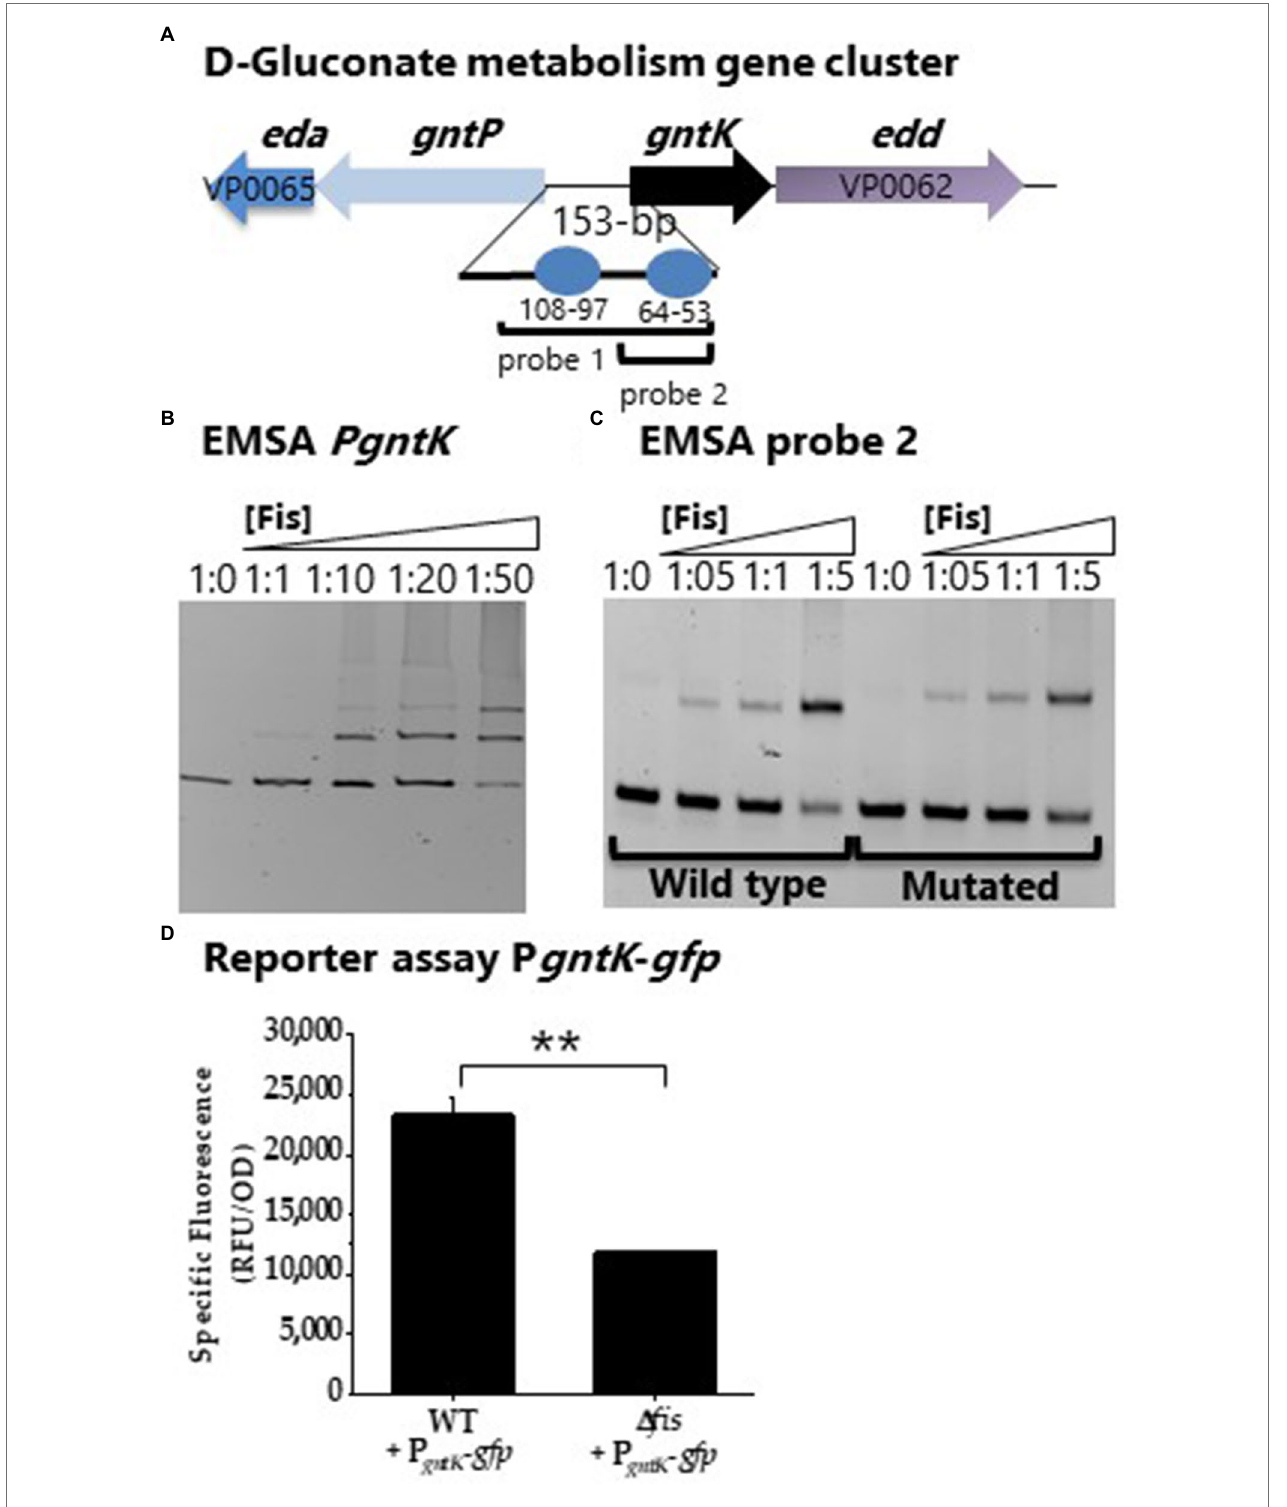
FIGURE 9 | Fis is a positive regulator of gntK . (A) Putative Fis binding sites in the regulatory region of gntK . (B) EMSA analysis with purified Fis protein and PgntK probe 1. DNA: protein ratios were as follows: 10, 1:1, 1:10, 1:20, 1:50. (C) EMSA analysis of probe 2 containing a single Fis BS and a mutated Fis BS probe 2. (D) GFP transcriptional reporter assay of gntK regulatory region in wild type and Δ fis . ** p <